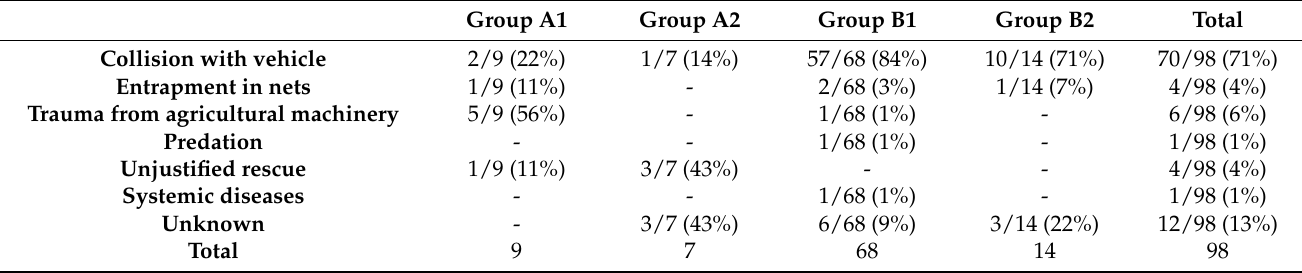
Table 2. Reason for hospitalisation in the cohort of 98 patients and categorised into groups. Group A1: deceased unweaned; Group A2: survived unweaned; Group B1: deceased weaned; Group B2: survived weaned.